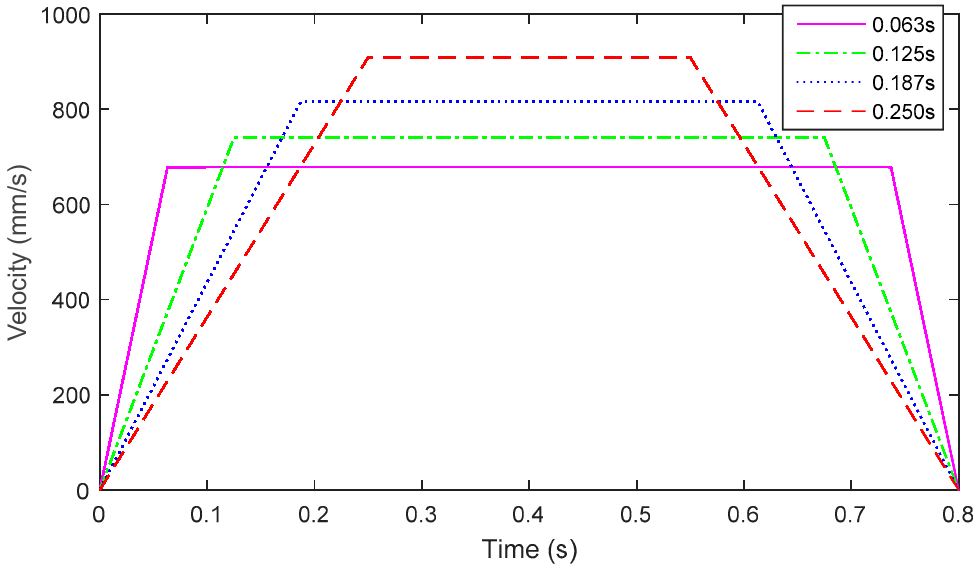
( b ) Figure 11. Position deviations at target point: ( a ) when 𝑡 (cid:3028) = 0.063 ; ( b ) when 𝑡 (cid:3028) = 0.250 . In the first experiment, the maximum velocities were identical for all cases, but the time taken to move was longer in case 4. To test the influence of the maximum velocity, motion profiles using the same time to move were designed as shown in Figure 12. The velocity in case 4 was then the largest. The amplitude and settling time in cases 2 and 4, in which the acceleration/deceleration time was a multiple of the vibration period of the natural frequency, were smaller than those in cases 1 and 3.